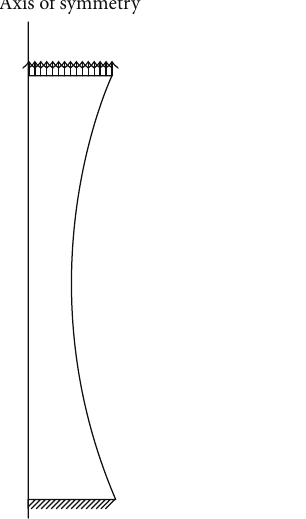
Figure 2: Boundary condition.